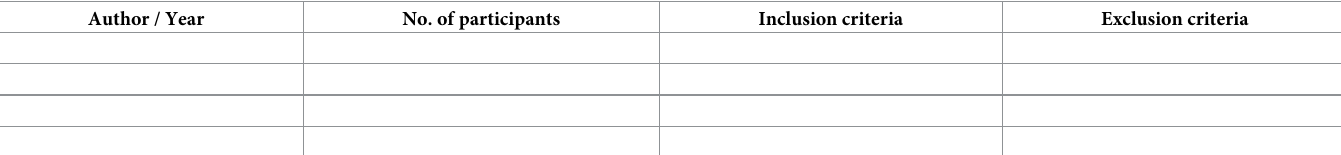
Table 1. Study characteristics related to the number of participants, inclusion and exclusion criteria.